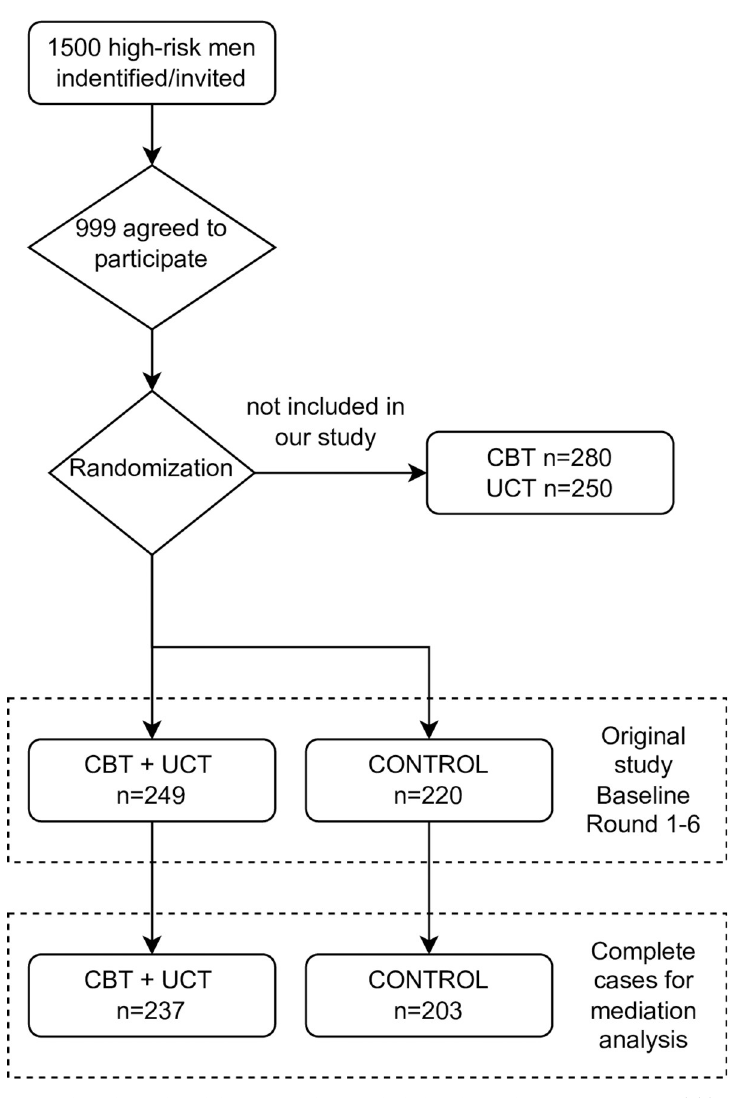
Fig 1. Flow chart of trial design and those included in the analysis. Open acces available information can be found at: https://www.nber.org/system/files/working_papers/w21204/w21204.pdf.